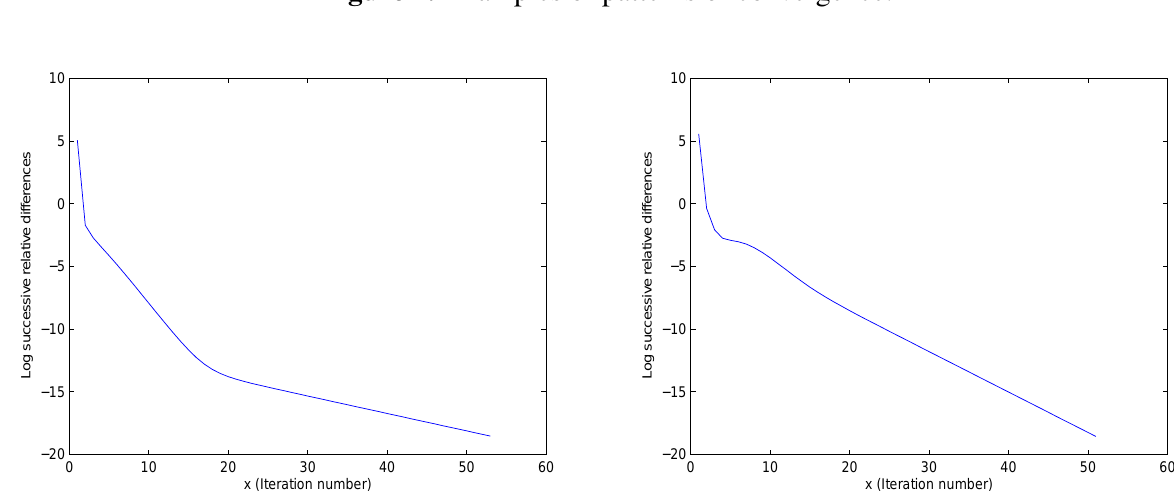
Figure 2. Examples of patterns of